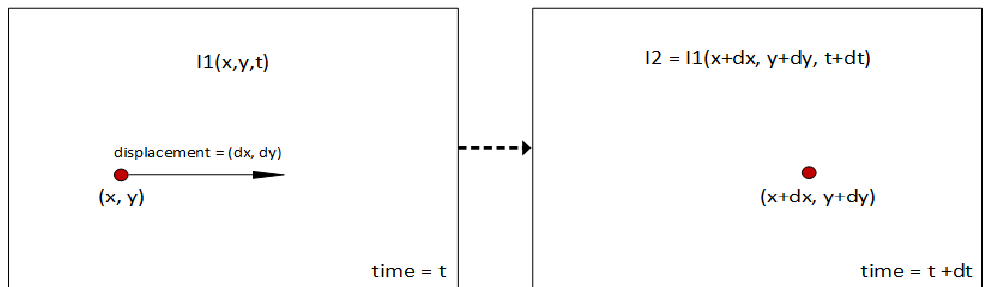
Figure 1. Optical